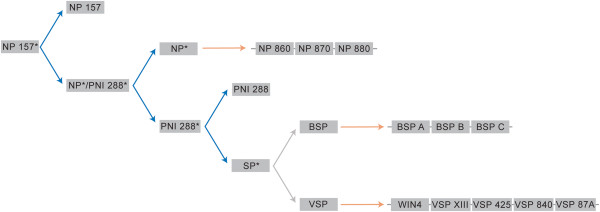
Hypothetical origin of the NP-like gene family in Populus trichocarpa. Blue arrows represent whole genome duplication events and orange arrows represent tandem duplication events. Asterisks denote ancestral genes with unknown sequence similarity to present-day genes.